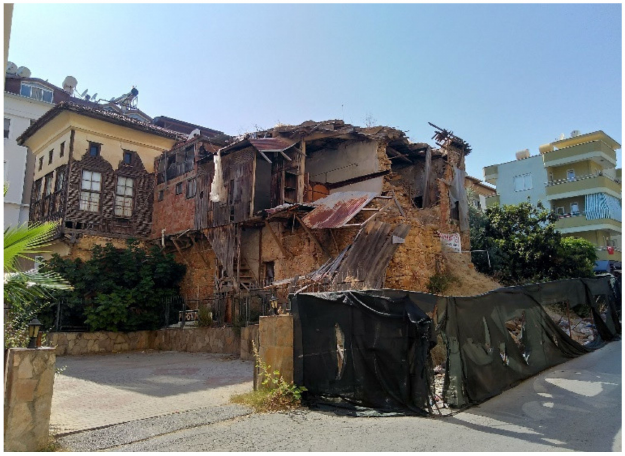
Figure 1. A deteriorated historic building in Turkey.